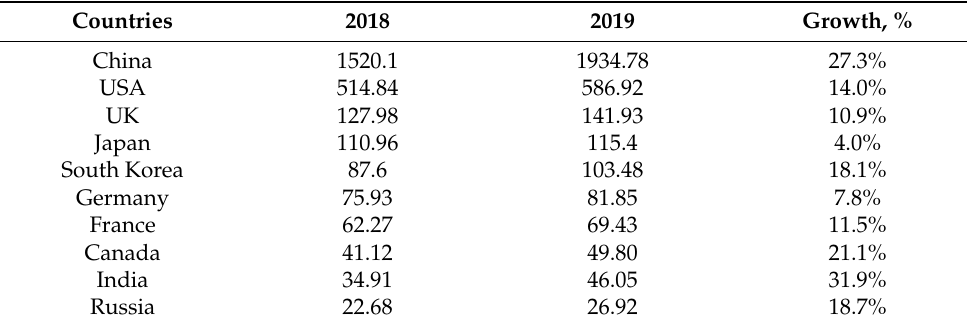
Table 1. Top 10 countries by e-commerce volumes in 2018–2019, billion USD.